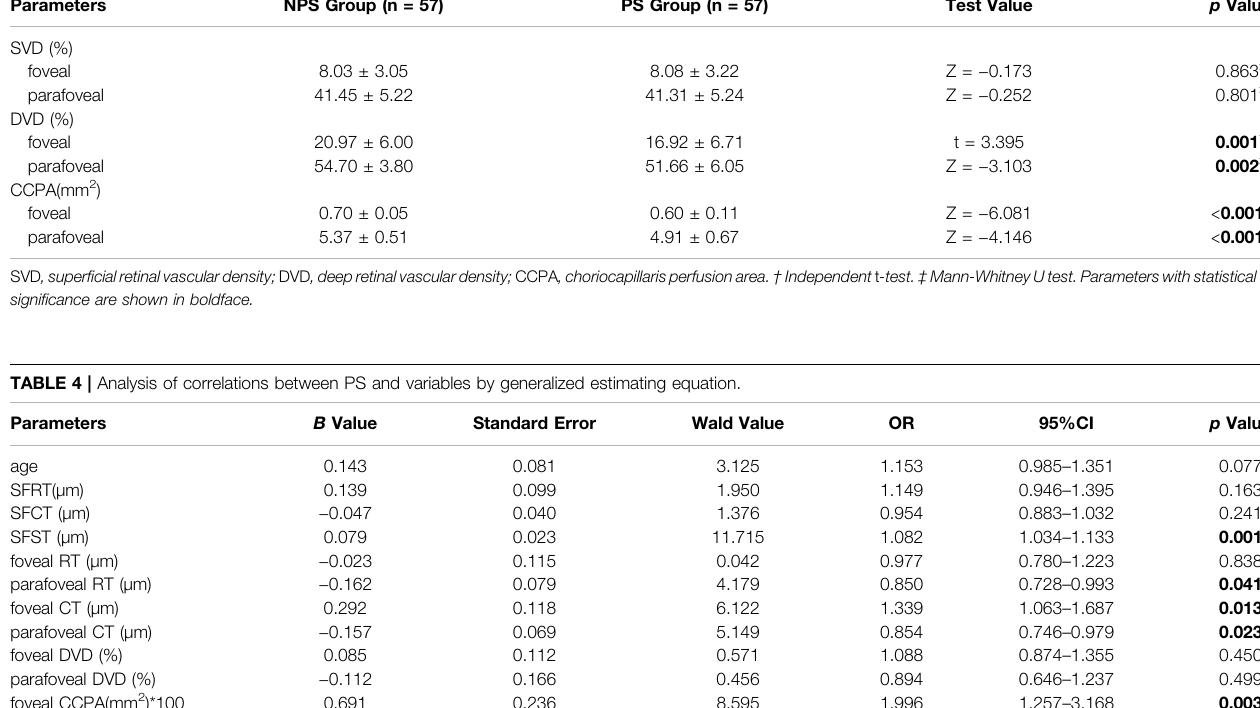
TABLE 3 | Comparison of SVD, DVD, and CCPA of NPS group and PS group. Parameters